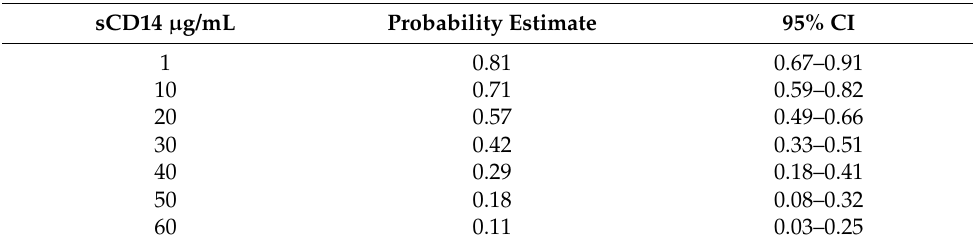
Table 4. Probability of belonging to group D with 95% CI for selected values of sCD14 in µ